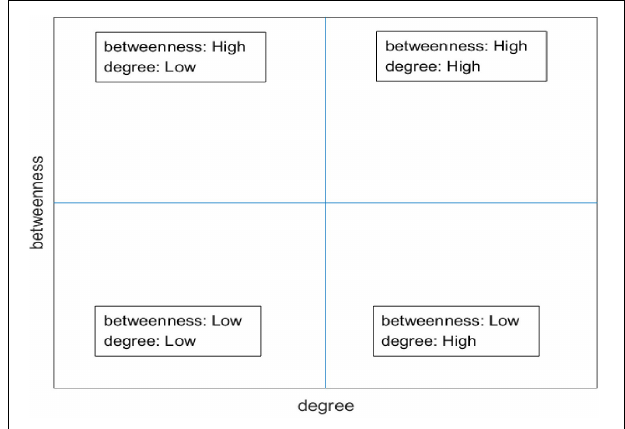
FIGURE 1 | The node centrality